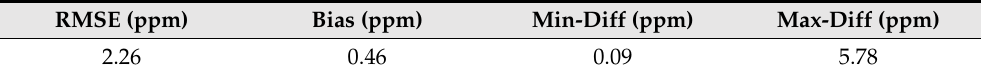
Figure 8. Comparison of wet refractivity to the profile derived from radiosonde observations in epochs 14,124, 14,484, 14,844, and 15,204, from left to right. Table 1. The statistical measures between the validation data and outputs over the processing